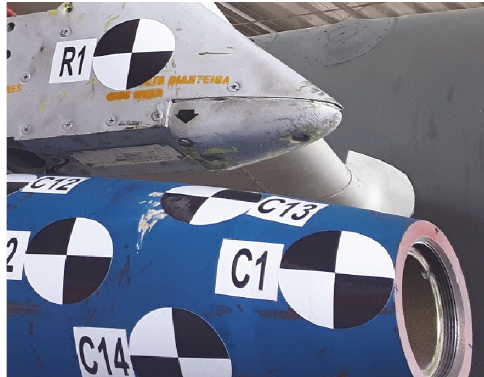
Figure 5: Example of a marker used in the store separation.